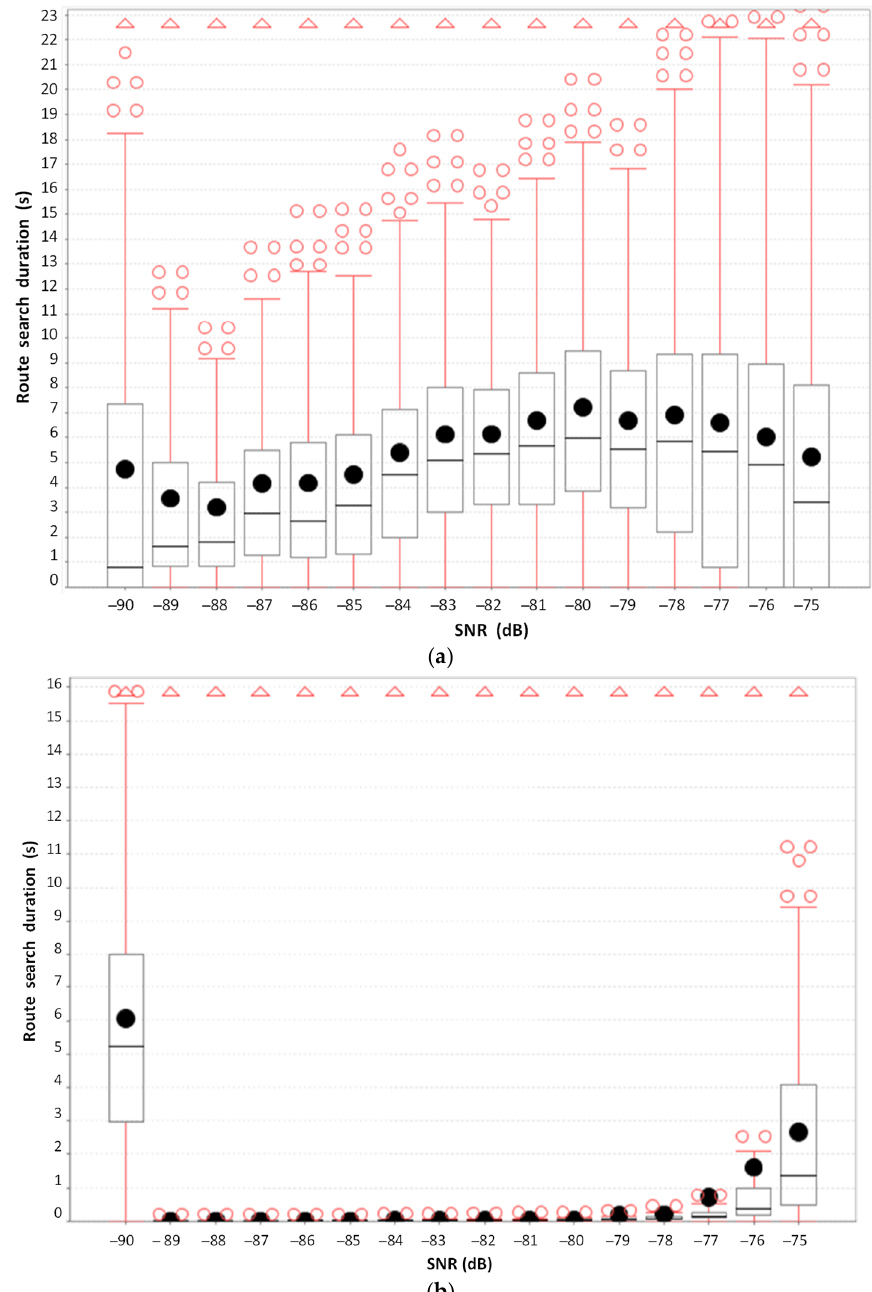
Figure 18. Dependence of the route search duration in a wireless self-organizing network on the radio channel parameters: ( a ) using the classical greedy routing algorithm; ( b ) proposed solution.